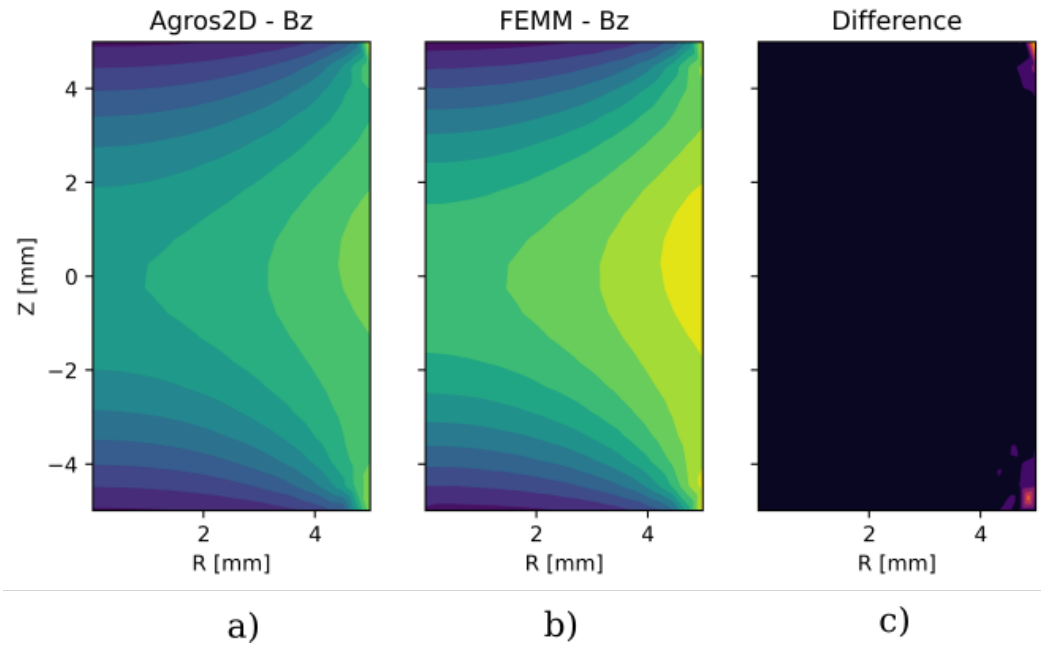
Figure 4. The pictures ( a , b ) show the calculated flux density values in the upper half of the examined region with the two types of software compared: Agros2d ( a ) and FEMM ( b ). The third picture ( c ) shows the dependence of the B z values on the meshing properties.